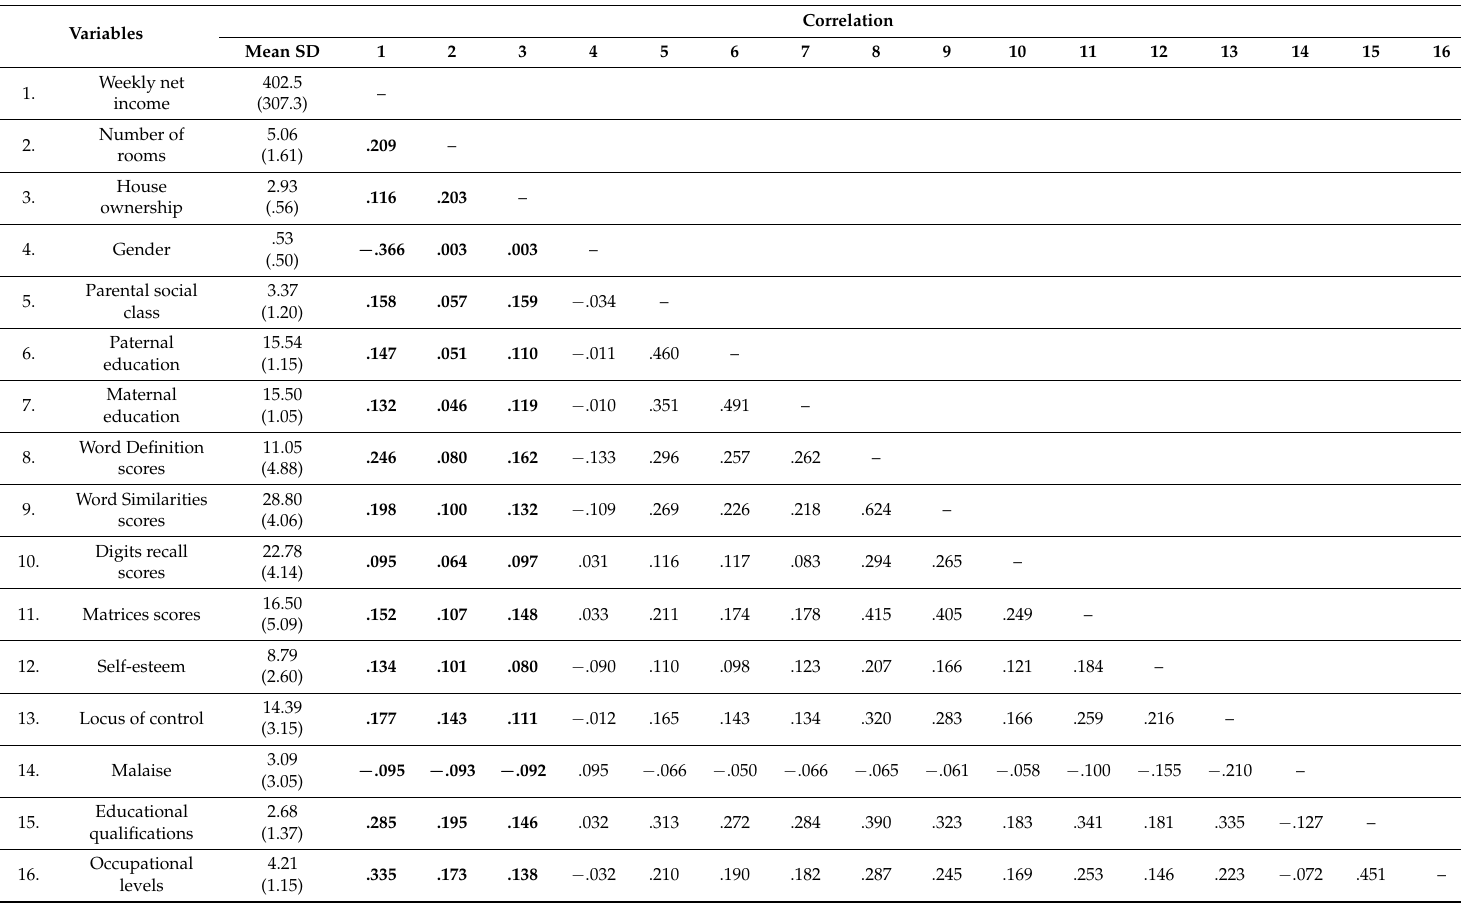
Table 1. Pearson correlations among gender, parental social status measures, childhood intelligence measures, locus of control, self-esteem, educational qualifications and occupational levels, and adult financial well-being